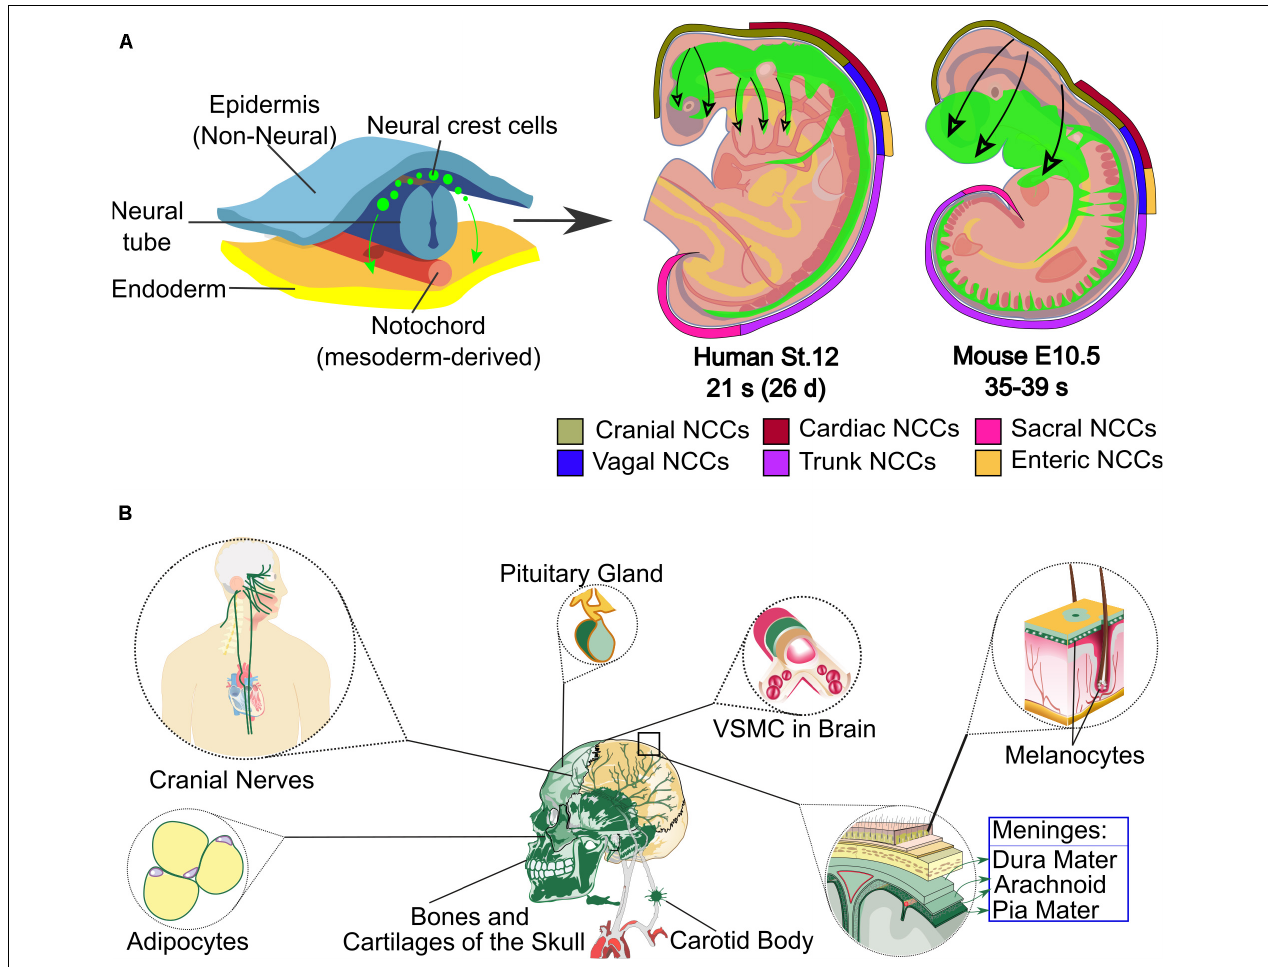
FIGURE 1 | Neural crest origin, regions in human and mouse embryos and some of its cranial derivatives. (A) The top-left part of the scheme shows the origin of the neural crest cells (green) that migrate through the embryo. On the top-right side, the level of axial origin (see axial color key) of different regions of the neural crest is represented in developing mouse or equivalent human embryos; the migration of neural crest is represented in green inside the embryos and the direction of migration is marked with black arrows. Depending on their axial level of origin and migratory pathways, neural crest cells adopt different fates and contribute to various tissues and organs. (B) The main cranial derivatives, labeled in green, are shown. Abbreviations: d, days, E, mouse embryonic stage; NCCs, Neural Crest Cells; s, somite; St, human stage; VSMC, vascular smooth muscle